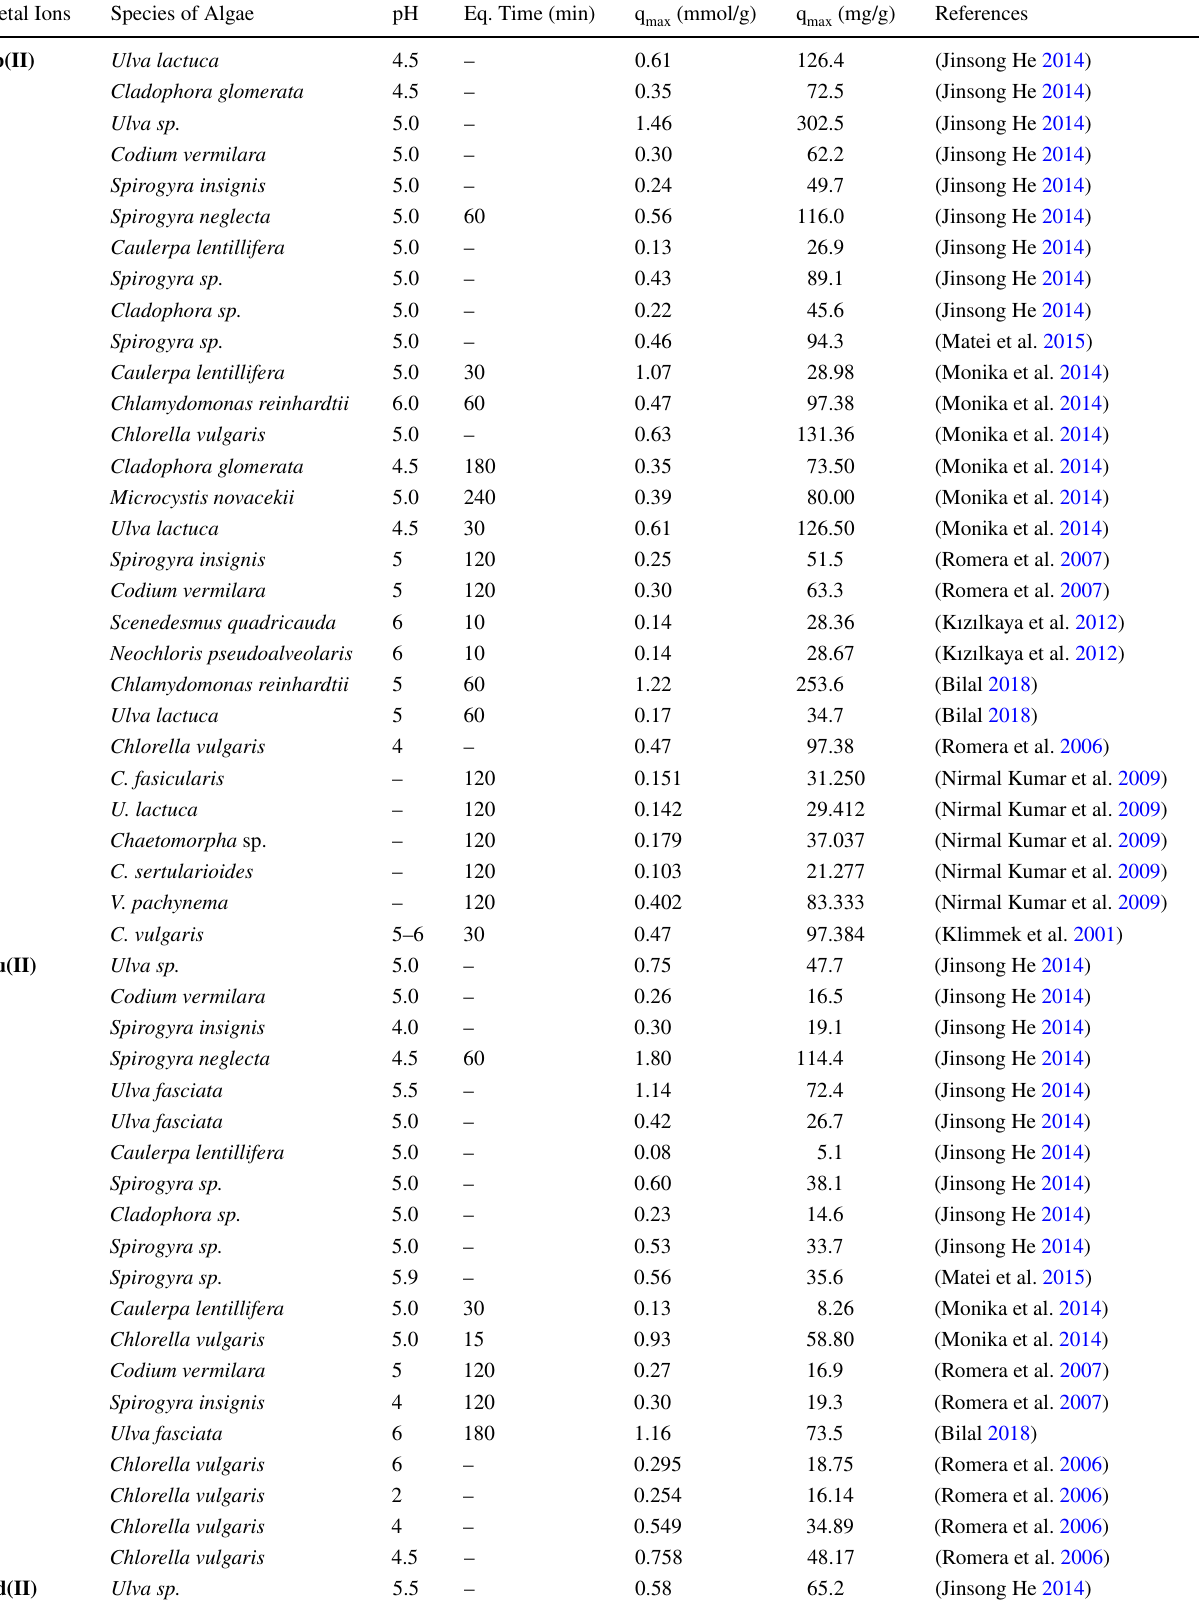
Table 6 Sorption parameters in monometallic systems for a number of green algae Metal